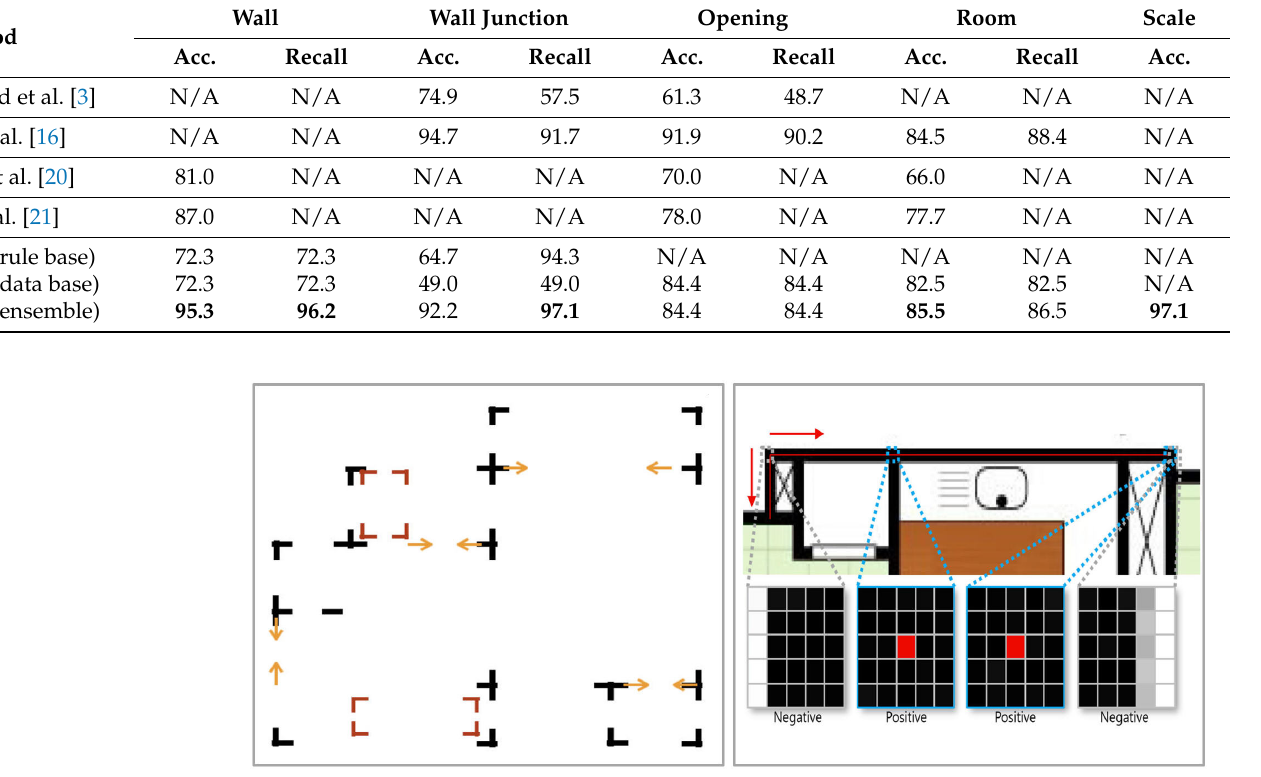
Figure 8. Detection methods of Liu et al. [16] ( left ), detection methods used in our study ( right